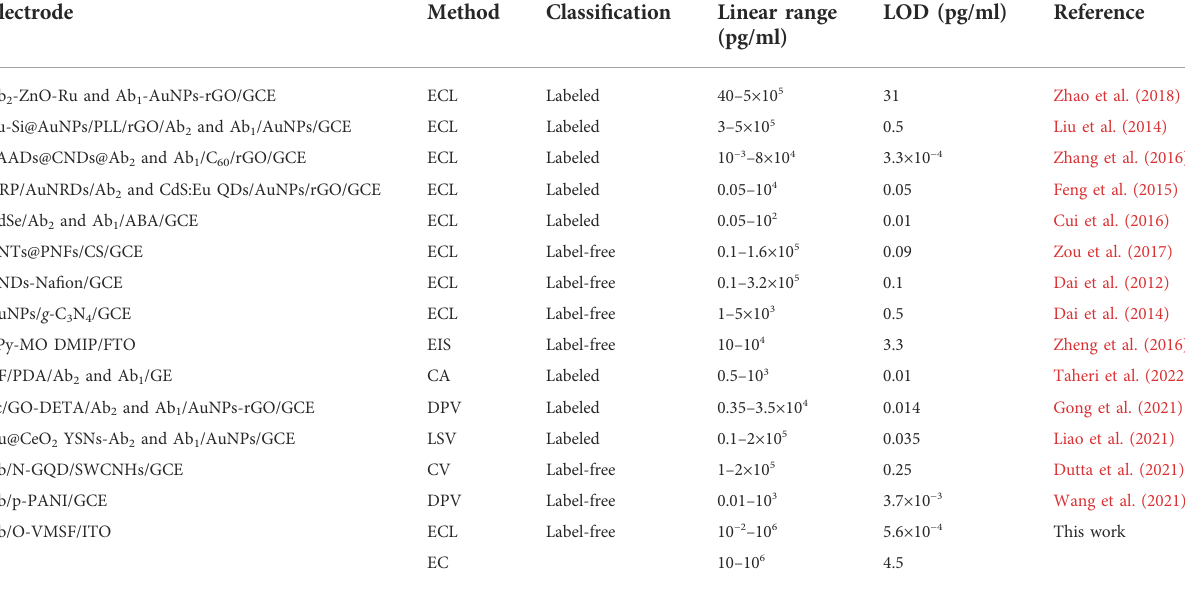
Ab, antibody; AuNPs, gold nanoparticles; rGO, reduced graphene oxide; GCE, glassy carbon electrode; PLL, poly- L -lysine; PAADs, poly (amidoamine) dendrimers; CNDs, carbon nanodots; AuNRDs, gold nanorods; QDs, quantum dots; ABA, p -aminobenzoic acid; CNTs, carbon nanotubes; PNFs, produced nano fi bers; CS, chitosan; g -C 3 N 4 , graphite-like carbon